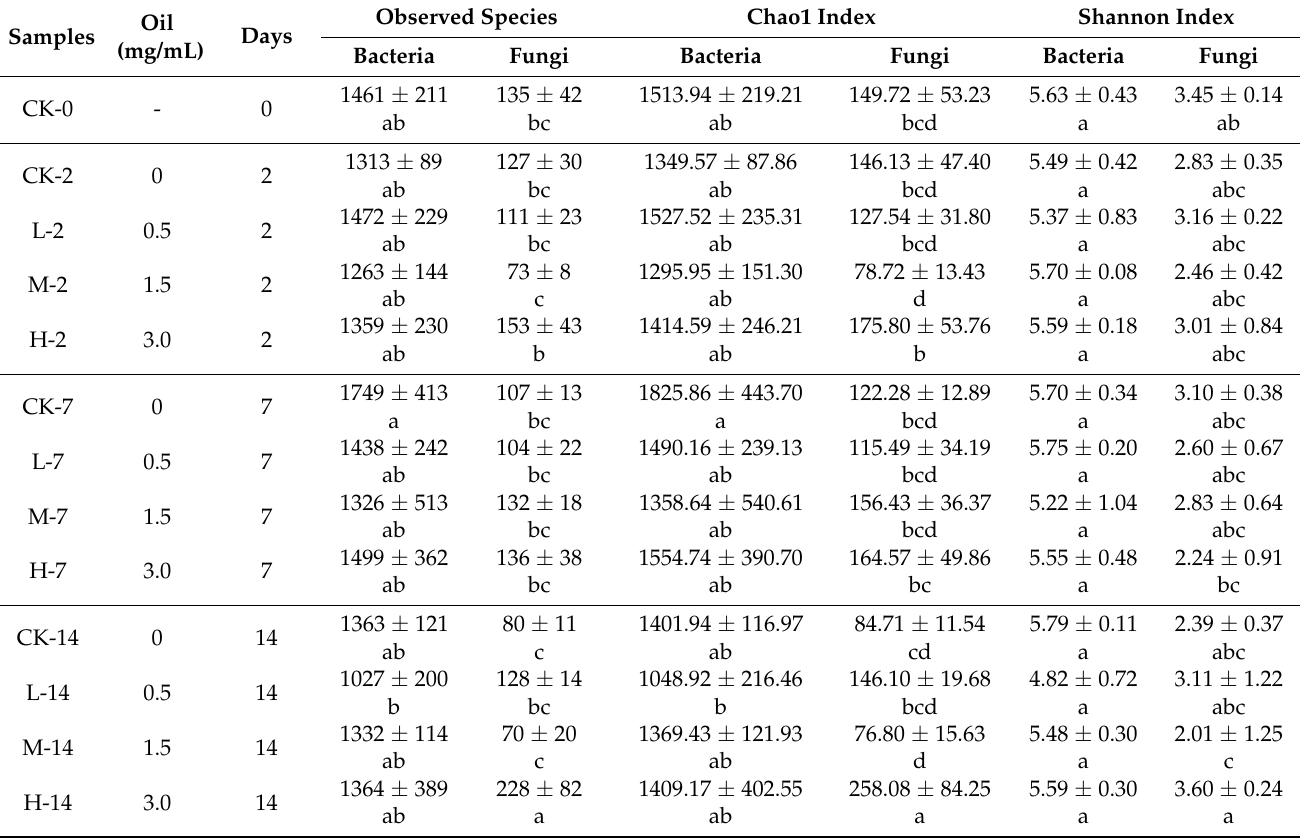
Table 1. Alpha-diversity indexes of soil microorganisms in soil samples exposed to oil from A. villosum whole